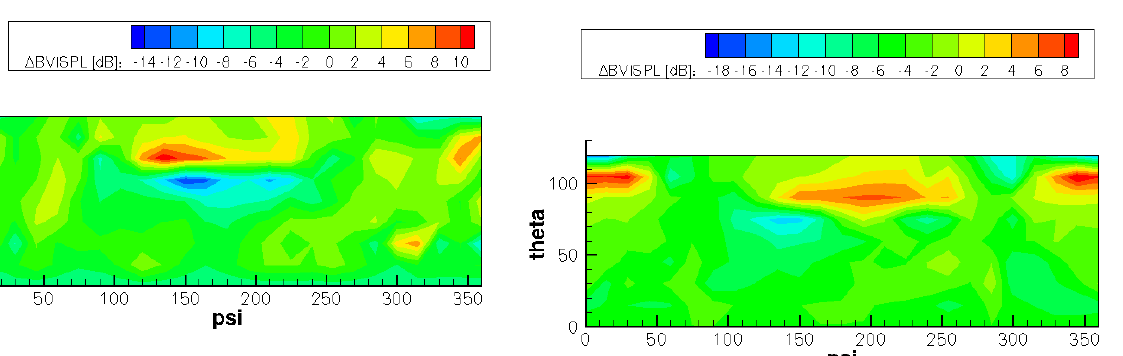
Figure 18: Technique B – C differential BVISPL at point 4 in maneu- ver ID8021.